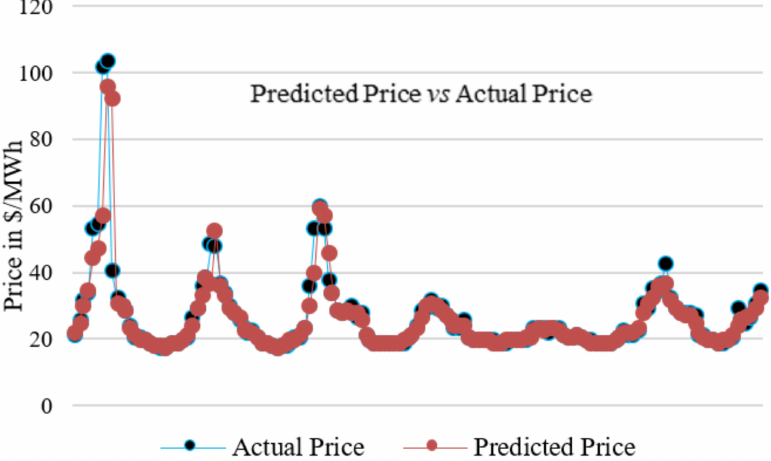
Figure 10. Hour-ahead forecasted settlement point price by the proposed ILRCN model vs. the actual